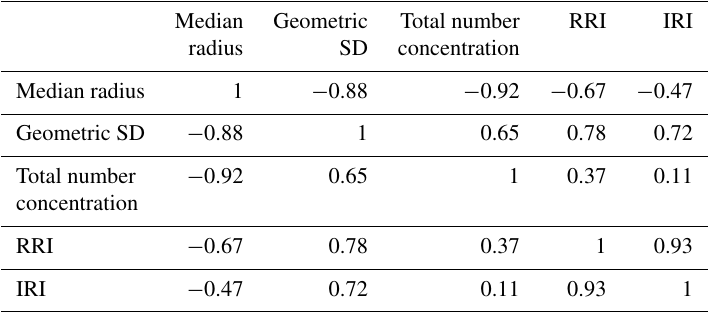
Table 5. State correlation matrix derived from the covariance matrix shown in Table 2, showing the correlations between retrieved variables for Case 1, assuming measurement errors of 5% for backscatter and 20% for extinction and a priori uncertainties from Table 3.